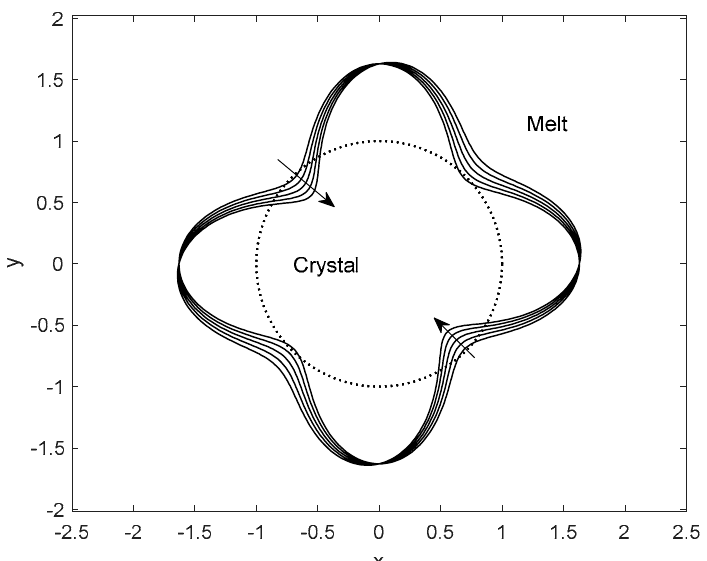
Figure 4. The cross-sectional curves of the interface morphology of the columnar crystal affected by the shear flow at different shear rates A 0 = B 0 = 0,40,80,120,160 at time t = 2, where α 4 = 0.25, r 0 = 1.1 R ∗ , Γ = 0.4545, and ∆ T = 10. By contrast, the dashed line denotes the columnar crystal without the anisotropic effect of interface energy. Arrows indicate crystal growth trends.